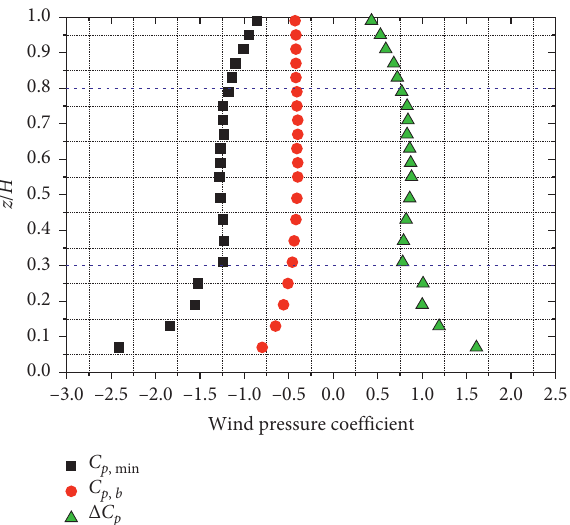
Figure 6: Characteristic value of pressure coefficients varying with